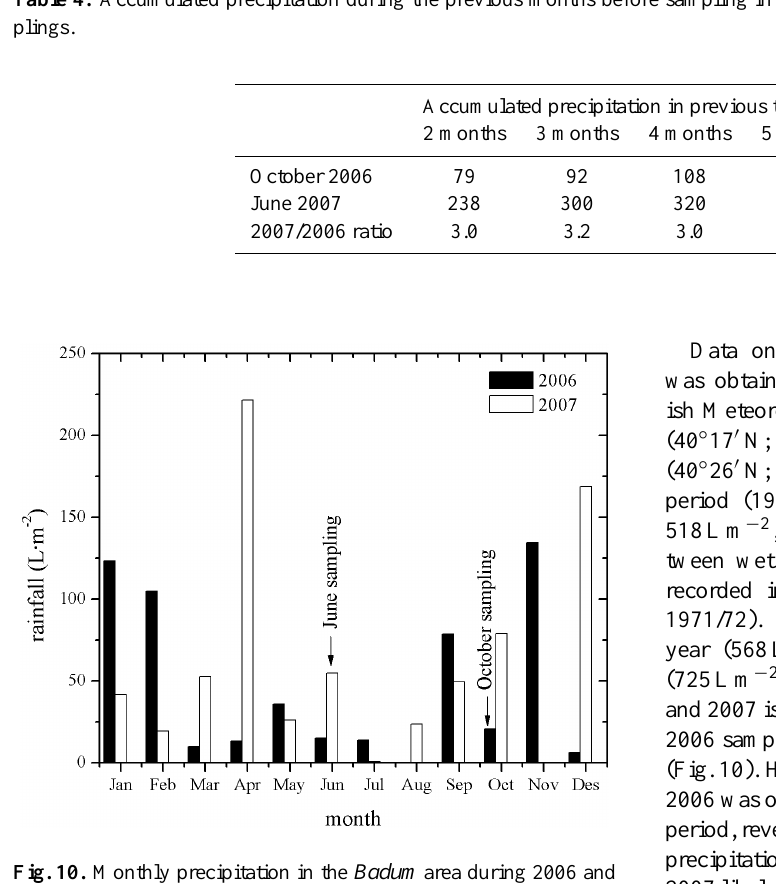
Fig. 10. Monthly precipitation in the Badum area during 2006 and 2007. The dates of the sampling campaigns are indicated. The high- est precipitation peak was observed in April 2007, while September 2006 also represented, to a lesser extent, a wet